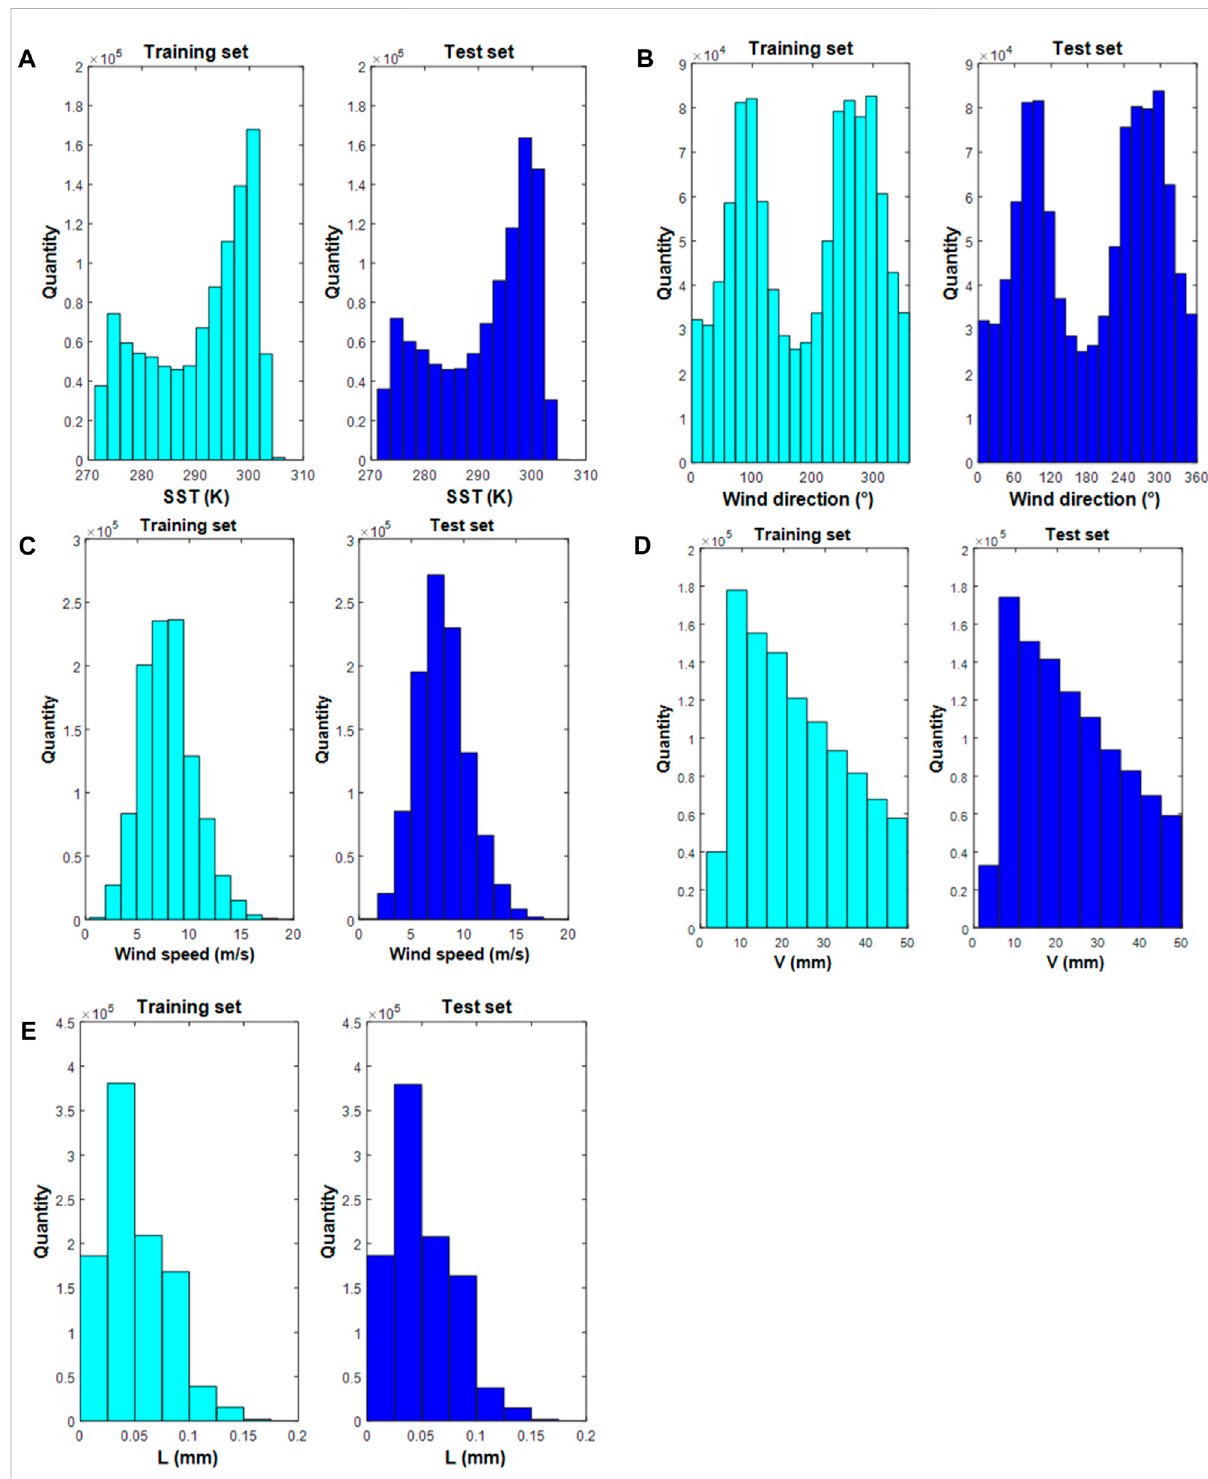
FIGURE 4 Histograms of the atmospheric-ocean background fi eld data. The training set is shown on the left and the test set on the right. (A) SST; (B) sea surface wind direction; (C) sea surface wind speed; (D) water vapor content; and (E) liquid water